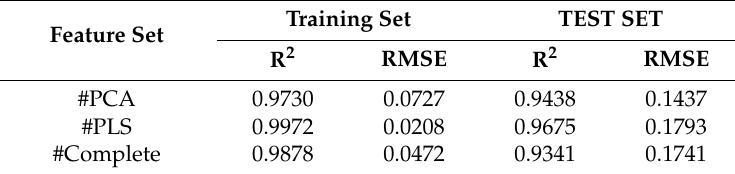
Table 7. Comparison of the #PCA, #PLS, and #Complete parameters with the ELM model.